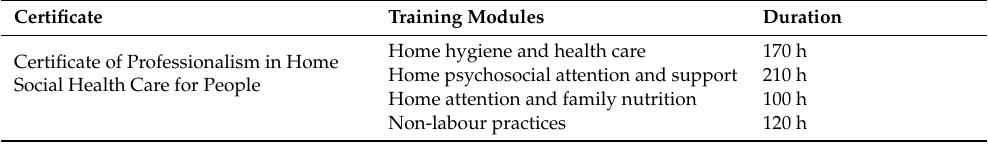
Table 1. Training that qualifies a person to work as a homecare support worker